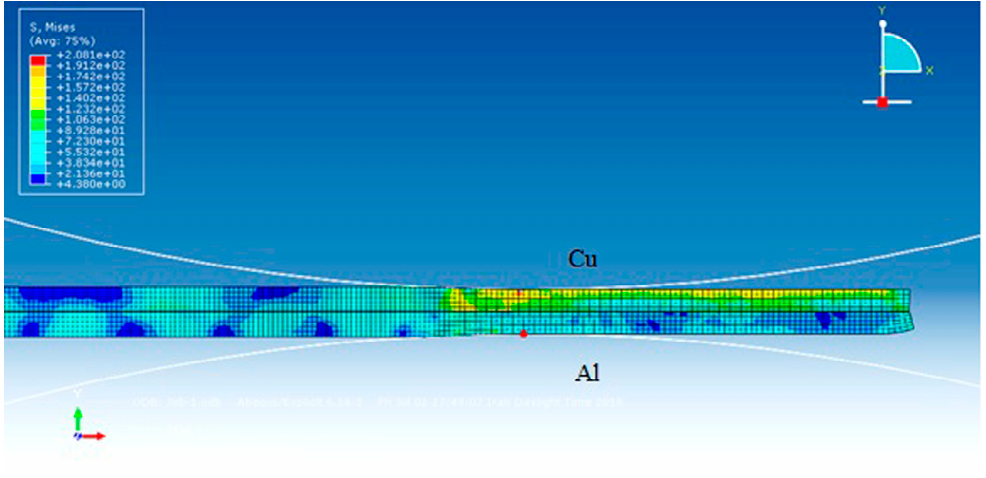
Figure 6. Rolling process of bimetal Al/Cu laminates.